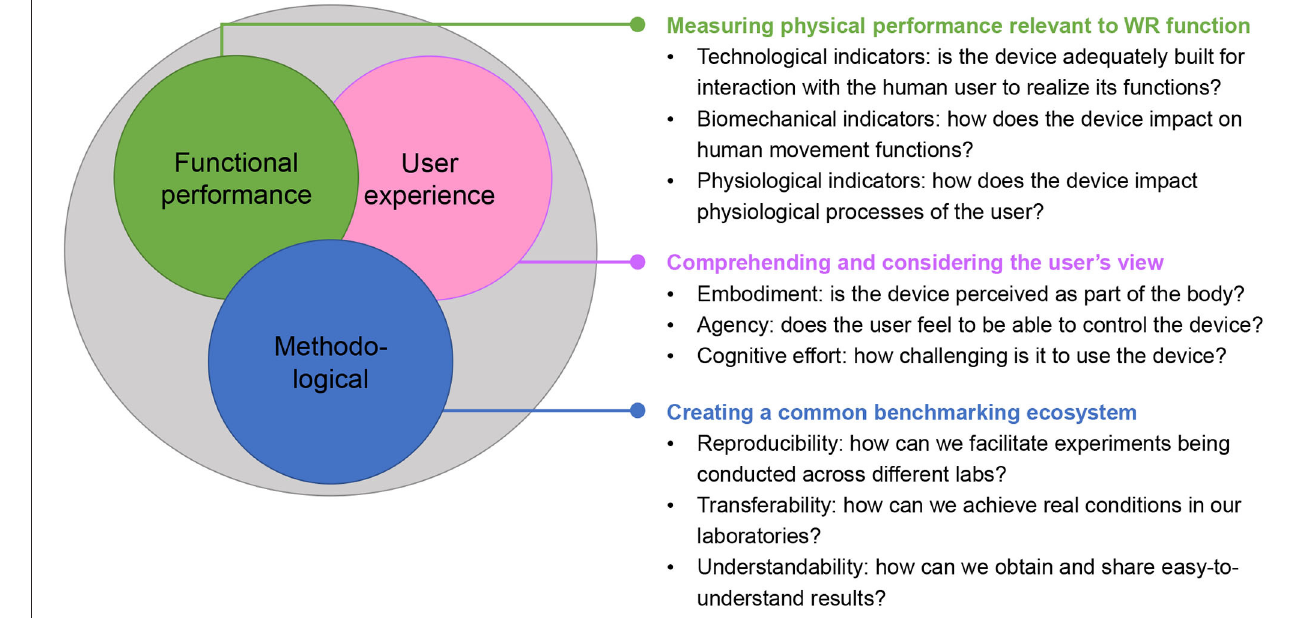
FIGURE 1 | Wearable robot benchmarking should be pushed from several perspectives. We advocate taking a look at functional performance, user experience and methodological aspects. To this end, we consider the sub-aspects and questions to outline research